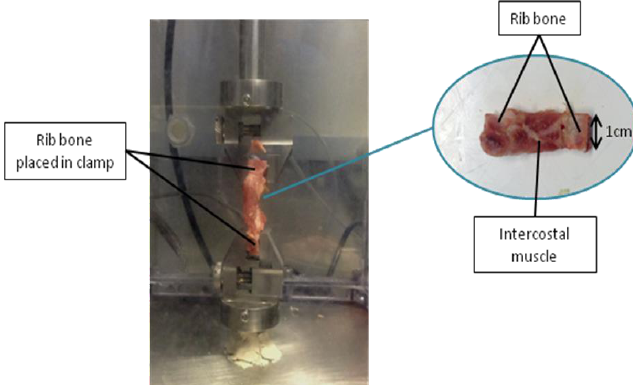
Figure1. Pork specimen clamped in bath via rib bones. Enlarged view of specimen illustrating preparation and size of sample.